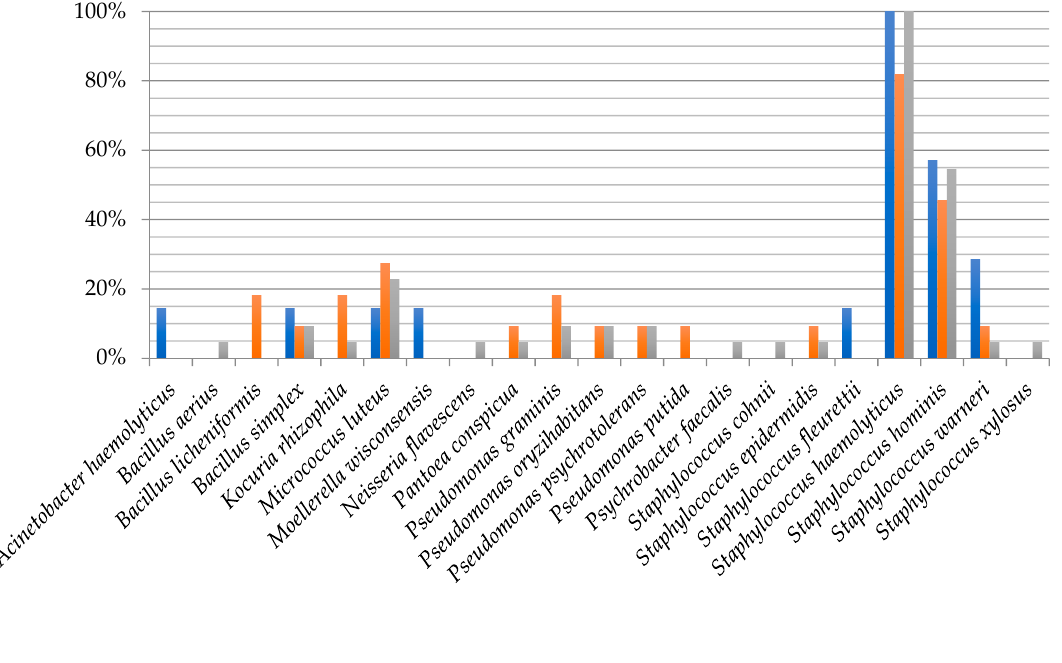
Figure 7. Frequency of the occurrence of bacteria on the foot skin depending on the physical activity frequency of examined people.